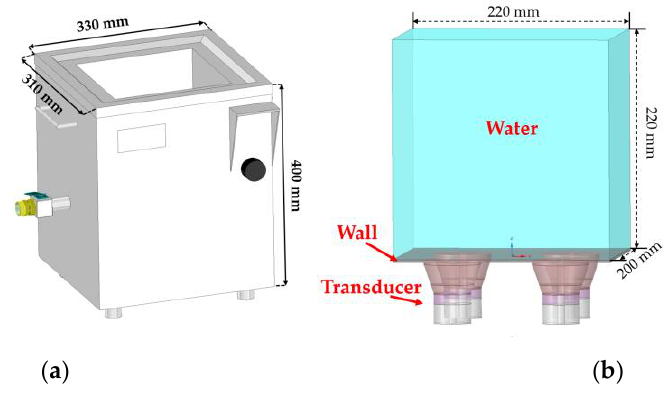
Figure 2. A conventional UCT: ( a ) CAD model and ( b ) simplified model.